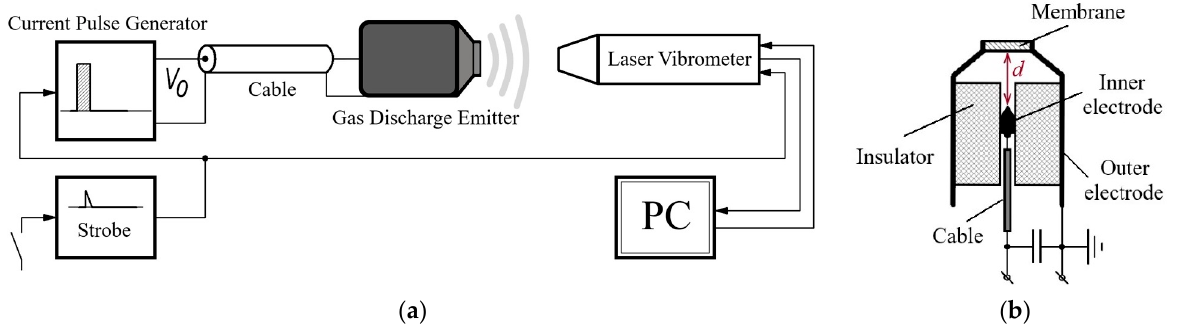
Figure 1. Simplified functional diagram ( a ) of the setup used for investigation of vibration charac- teristics of a gas discharge emitter ( b ).